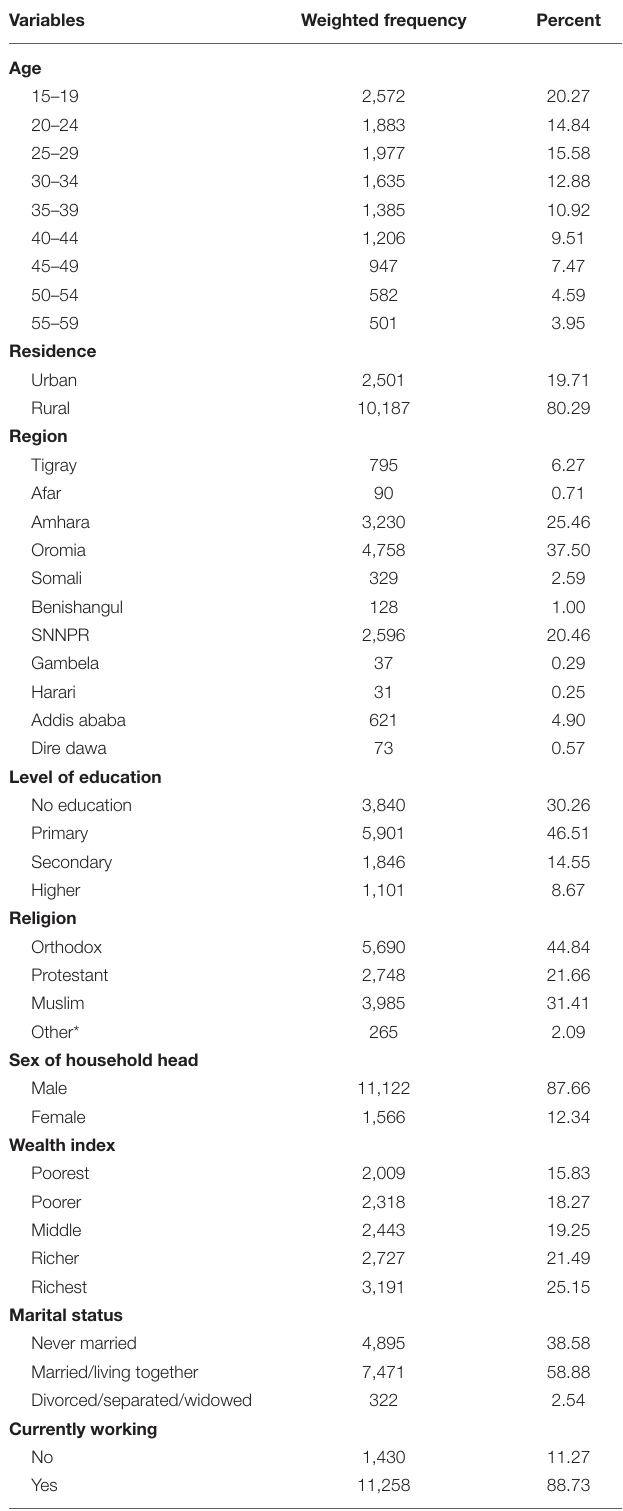
TABLE 2 | Socio-demographic characteristics of respondents in Ethiopia, 2016 ( N =